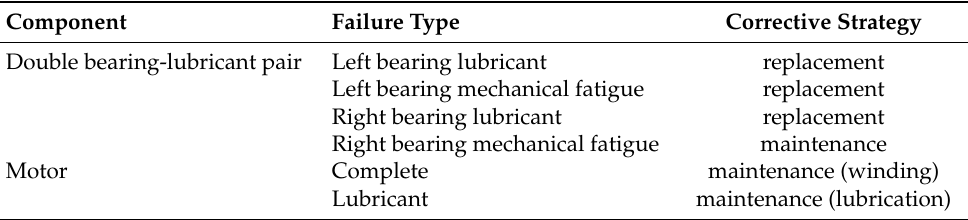
Table 24. Optimal corrective strategies for the model with standalone uncoated roller for the bleaching machine